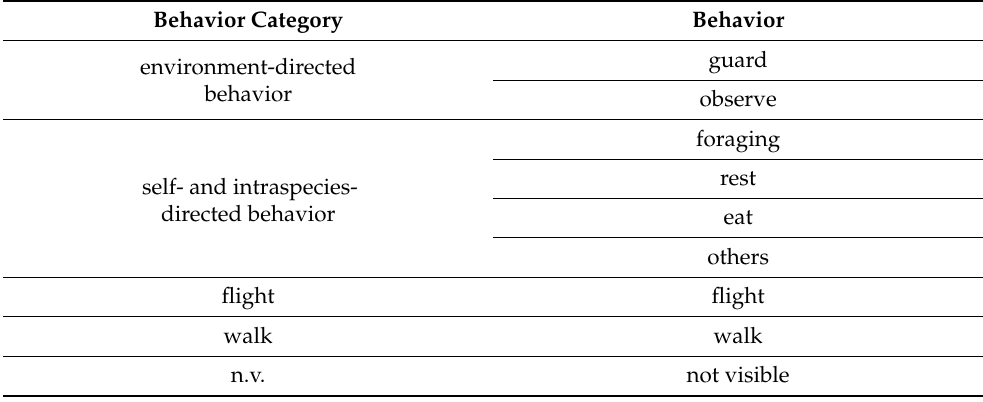
Table 2. Used ethogram of meerkat